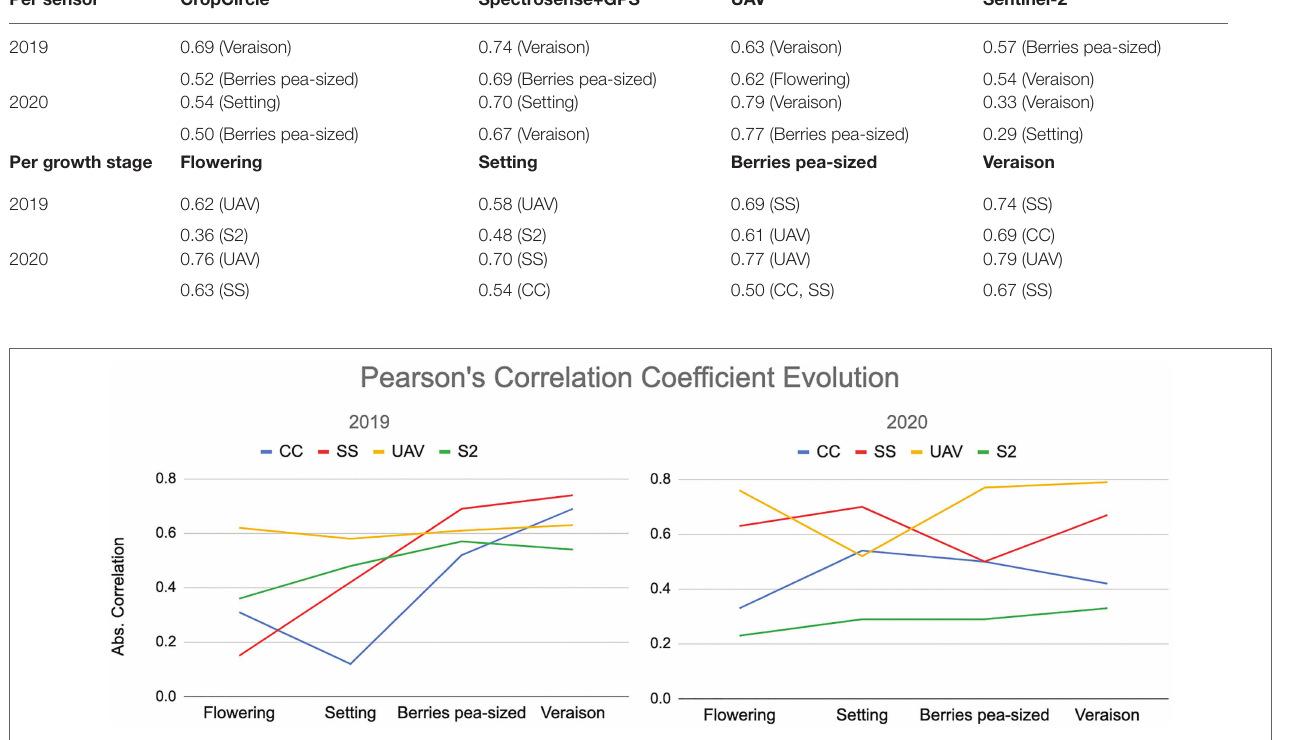
FIGURE 4 | Pearson’s correlation coefficients evolution throughout the growing seasons 2019 and 2020 (legend as for Table 3